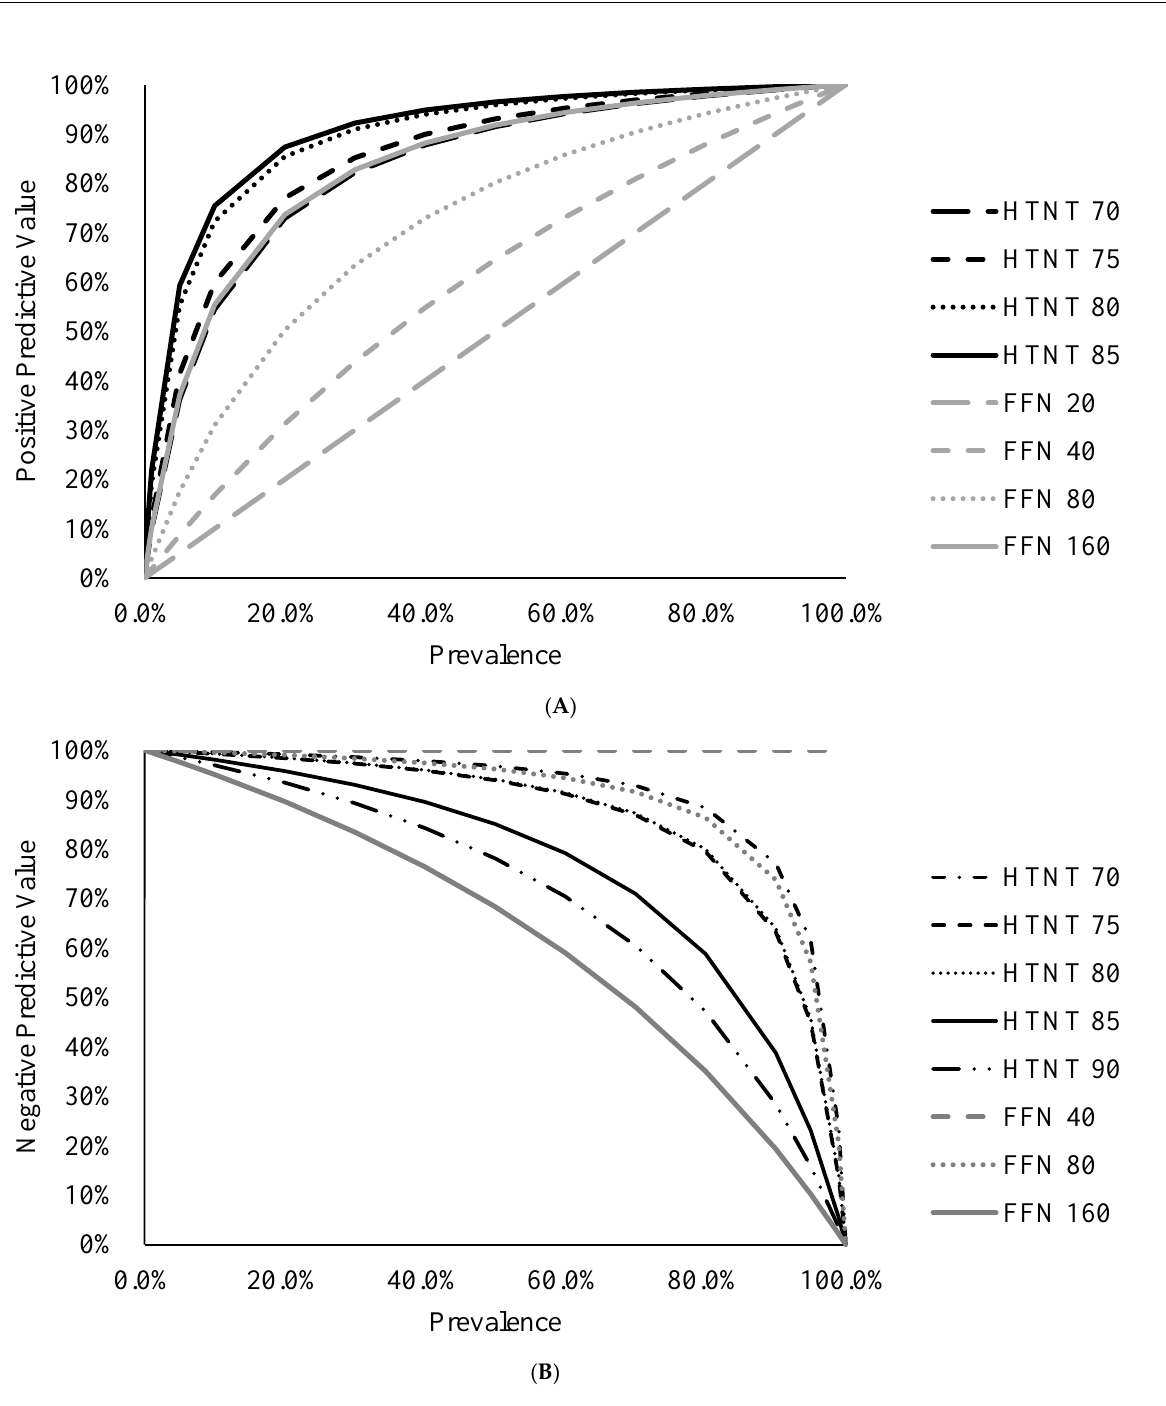
Figure 3. ( A ). Positive Predictive values for the HTNT (black lines) and FFN (gray lines) assays at various cutoffs. A cutoff of 90 is not represented for the HTNT. ( B ). Negative predictive values or the HTNT (black lines) and FFN (gray lines) assays at various cutoffs. A cutoff of 20 is not represented for the FFN assay.